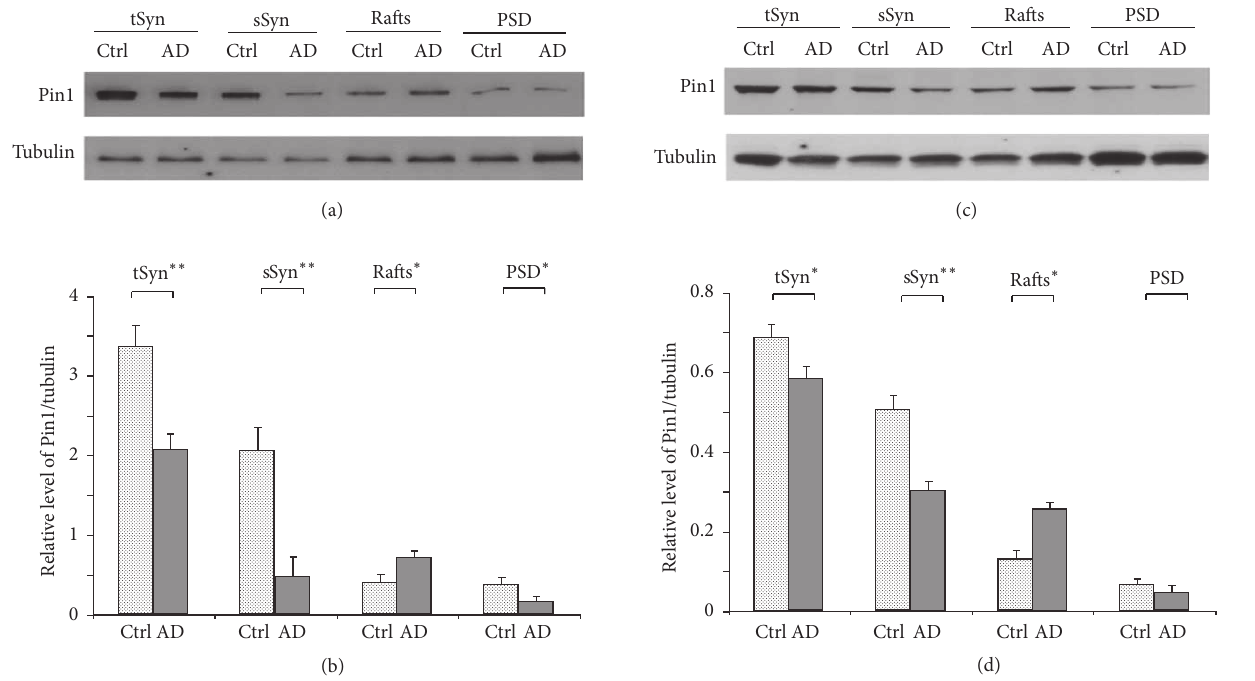
Figure 3: Pin1 proteins show pathological loss in the synapses of human AD and Tg2576 AD model mice. The Pin1 proteins in synaptosomes, soluble synaptosomes, dendritic rafts, and PSD fractions were isolated from human frontal cortical tissues (a and b) and from Tg2576 AD model mice cortical tissues (c and d) and were detected by Western blot. (a and c) Representative Western blot experiment. (b and d) Results from densitometric imaging of these same samples (human AD frontal cortical tissues, 𝑛 = 8 ; human frontal cortical tissues, 𝑛 = 5 ; Tg2576 mice, 𝑛 = 7 ; and wild-type mice, 𝑛 = 7 ; ∗ 𝑝 < 0.05 , ∗∗ 𝑝 < 0.01 ). Ctrl: human control frontal cortical tissues; AD: human AD frontal cortical tissues; tSyn: the supernatant of synaptosomes extracted by 1% SDS; sSyn: the supernatant of synaptosomes extracted by 0.5% Triton